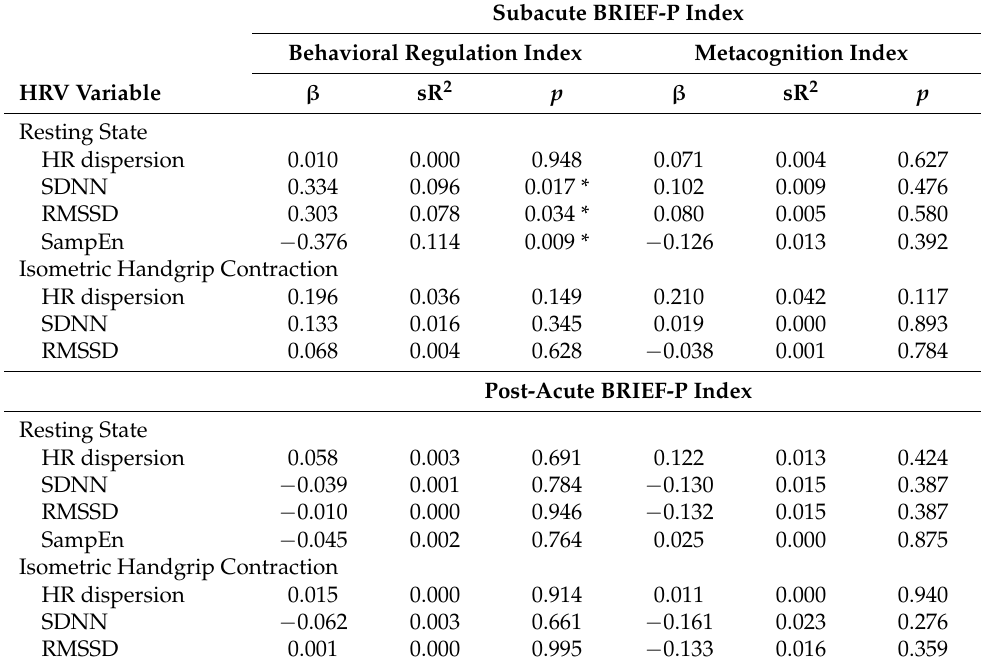
Table 6. Multivariate regression analyses for the Behavior Rating Inventory of Executive Function (BRIEF-P) a